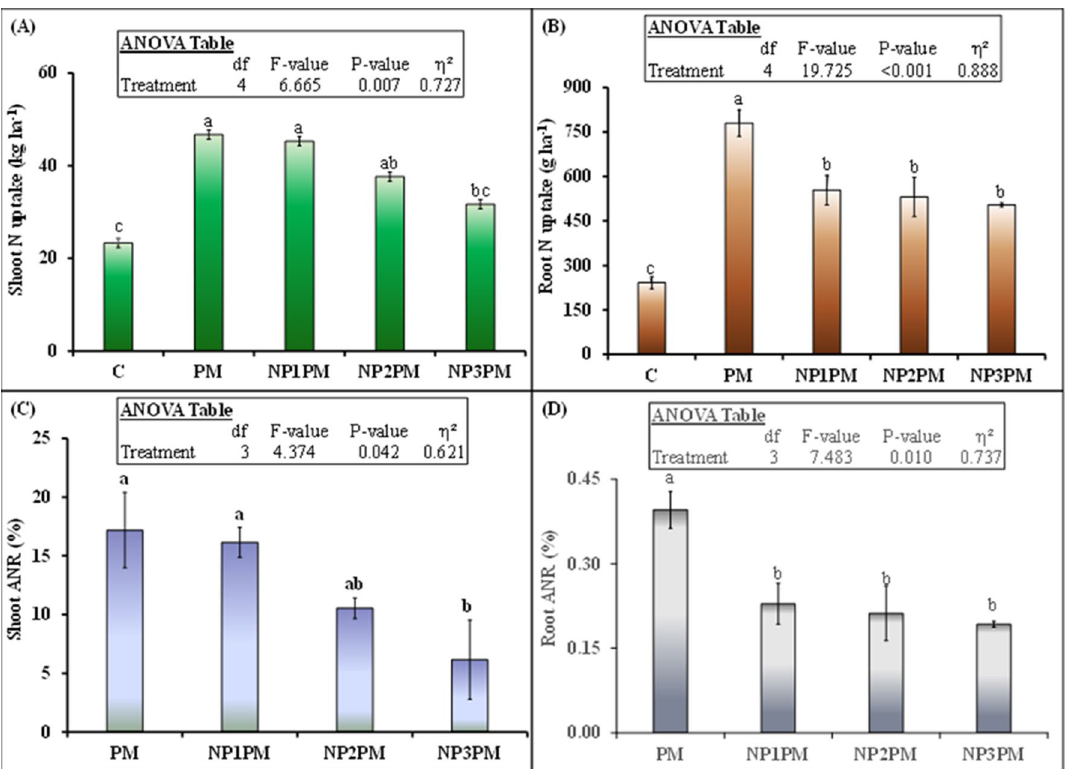
Figure 4. Mean (n = 3) ryegrass ( A ) shoot (cumulative of 3 cuts), ( B ) root N uptake as well as shoot ( C ) and root apparent N recoveries ( D ) after sole and combined application of poultry manure (PM) with nickel nanoparticle (NP). Treatments abbreviation can be found in the legend of Fig. 1. Error bars showed standard errors (± 1 SE) of the mean. Different small letters illustrated significant differences among treatments at a 5% probability level after the Tukey-HSD test. Inset table represented the outcomes of analysis of variance